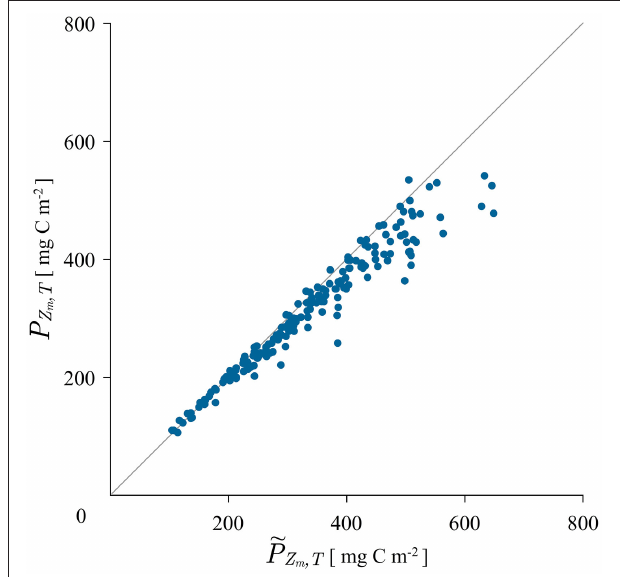
P Z calculated m , T e